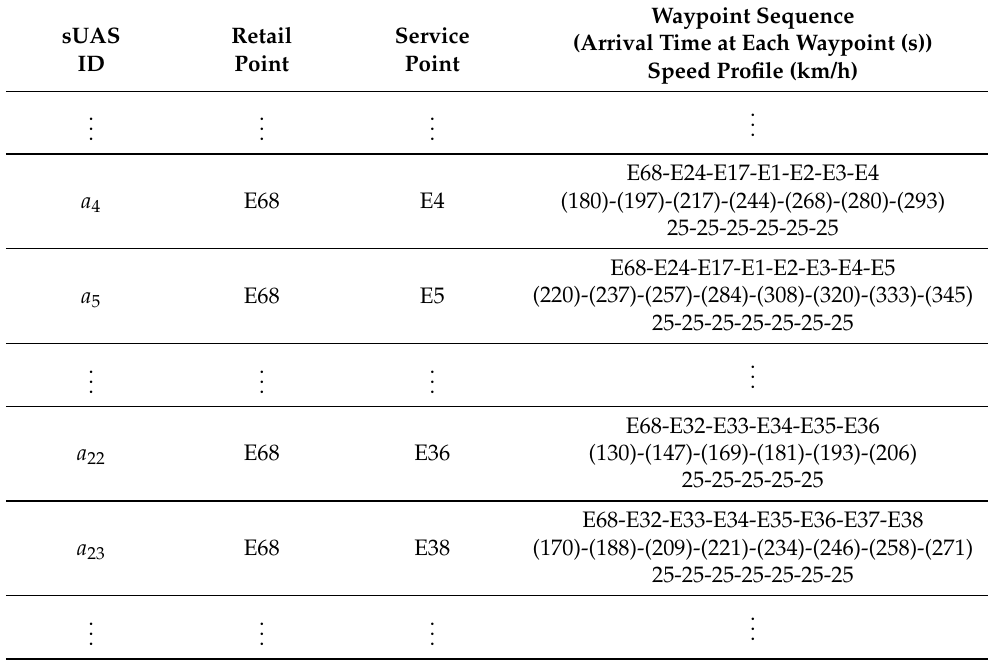
Table 1. Flight planning results of 30 sUASs for the 1-to- M case (outer loop: FCFS algorithm).